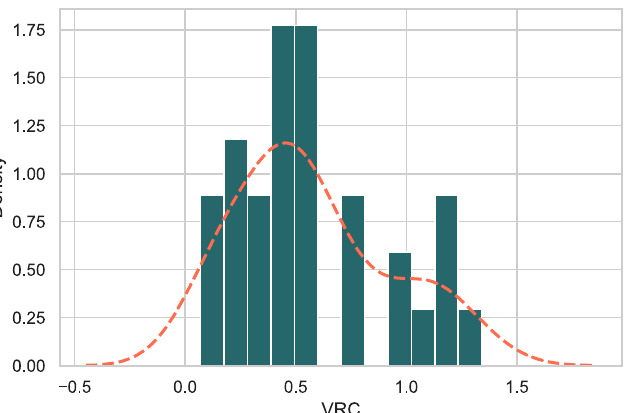
Figure 2. Histogram of VRC values across the 32 samples. The orange dashed line indicates a smoothed kernel density estimation (as implemented in Seaborn) of VRC values.